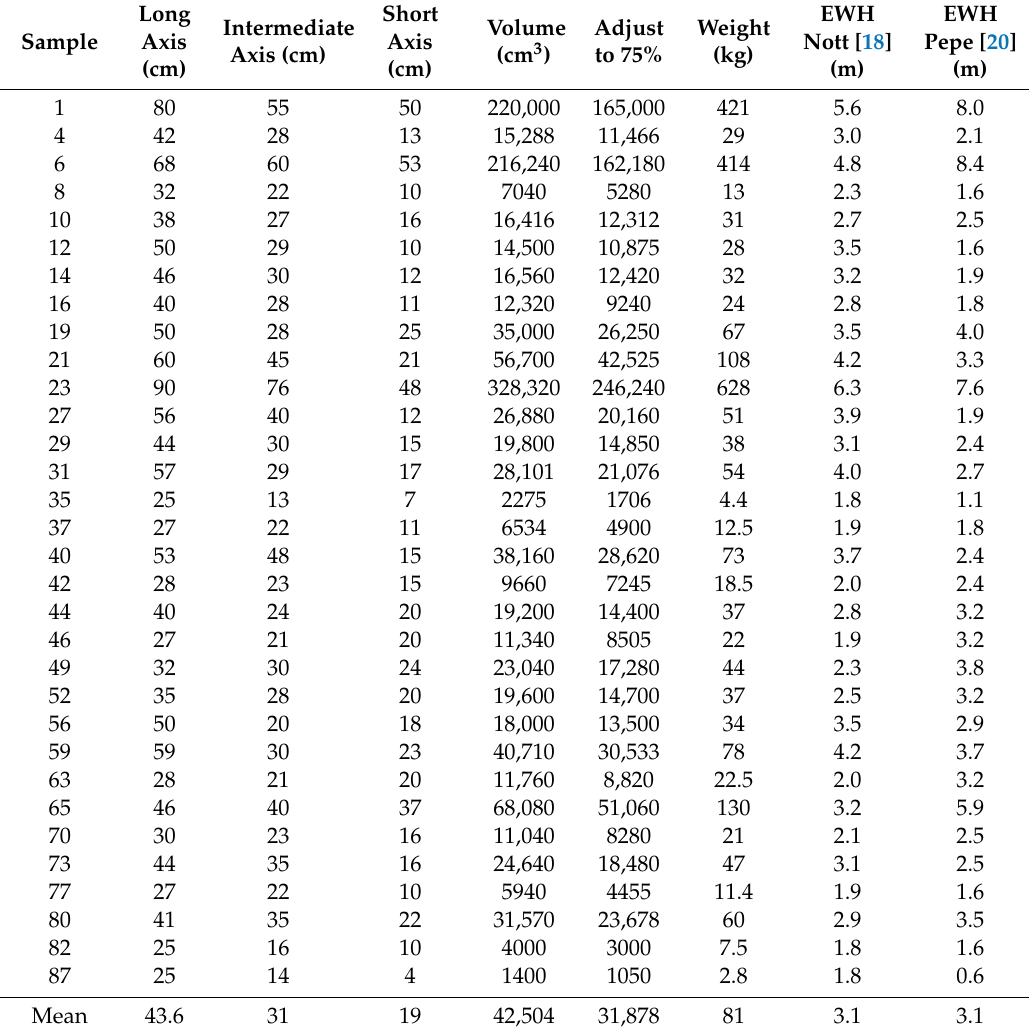
Table A1. Quantification of boulder size, volume, and estimated weight from selected coastal bar samples through transect 1 at Bah í a San Luis Gonzaga. EWH = estimated wave height. The density of Baja Californian andesite at 2.3 gm / cm 2 is applied uniformly in order to calculate wave height for each